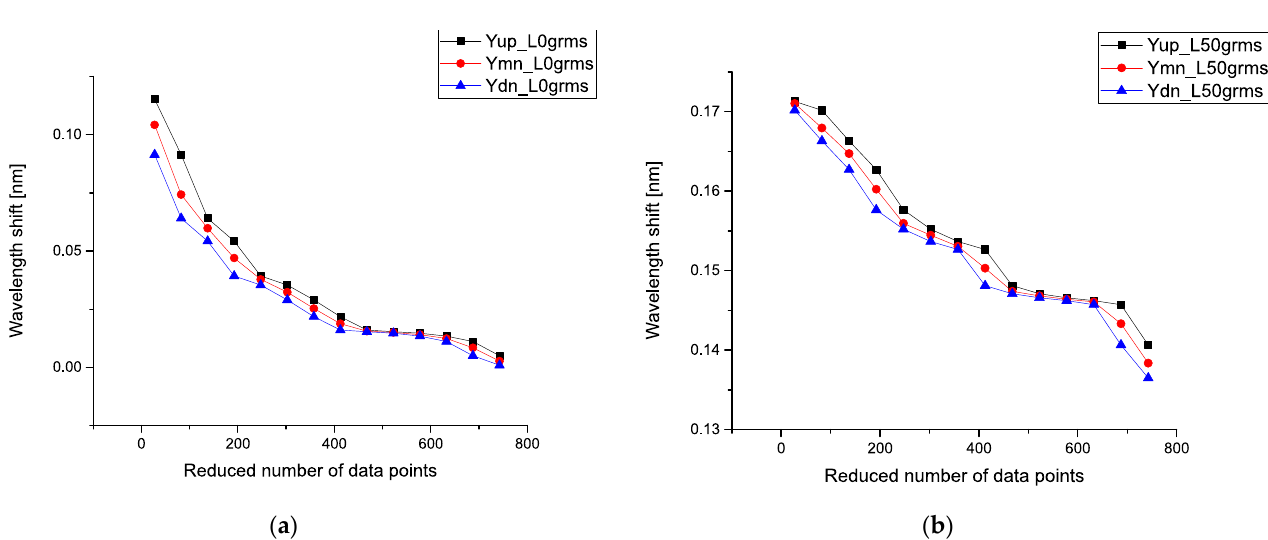
Figure 7. ( a ) Sequences of the ranged amplitudes (SRAs) calculated for the load L = 0 g; ( b ) curves of SRAs corresponding to L = 50 g. Other curves for the loads L = 60 – 100 g look similar and therefore are not shown. Black markers (Yup) denote the distribution of maximum values, red markers (Ymn) represent the distribution of mean values, and blue markers (Ydn) show the distribution of minimum values.